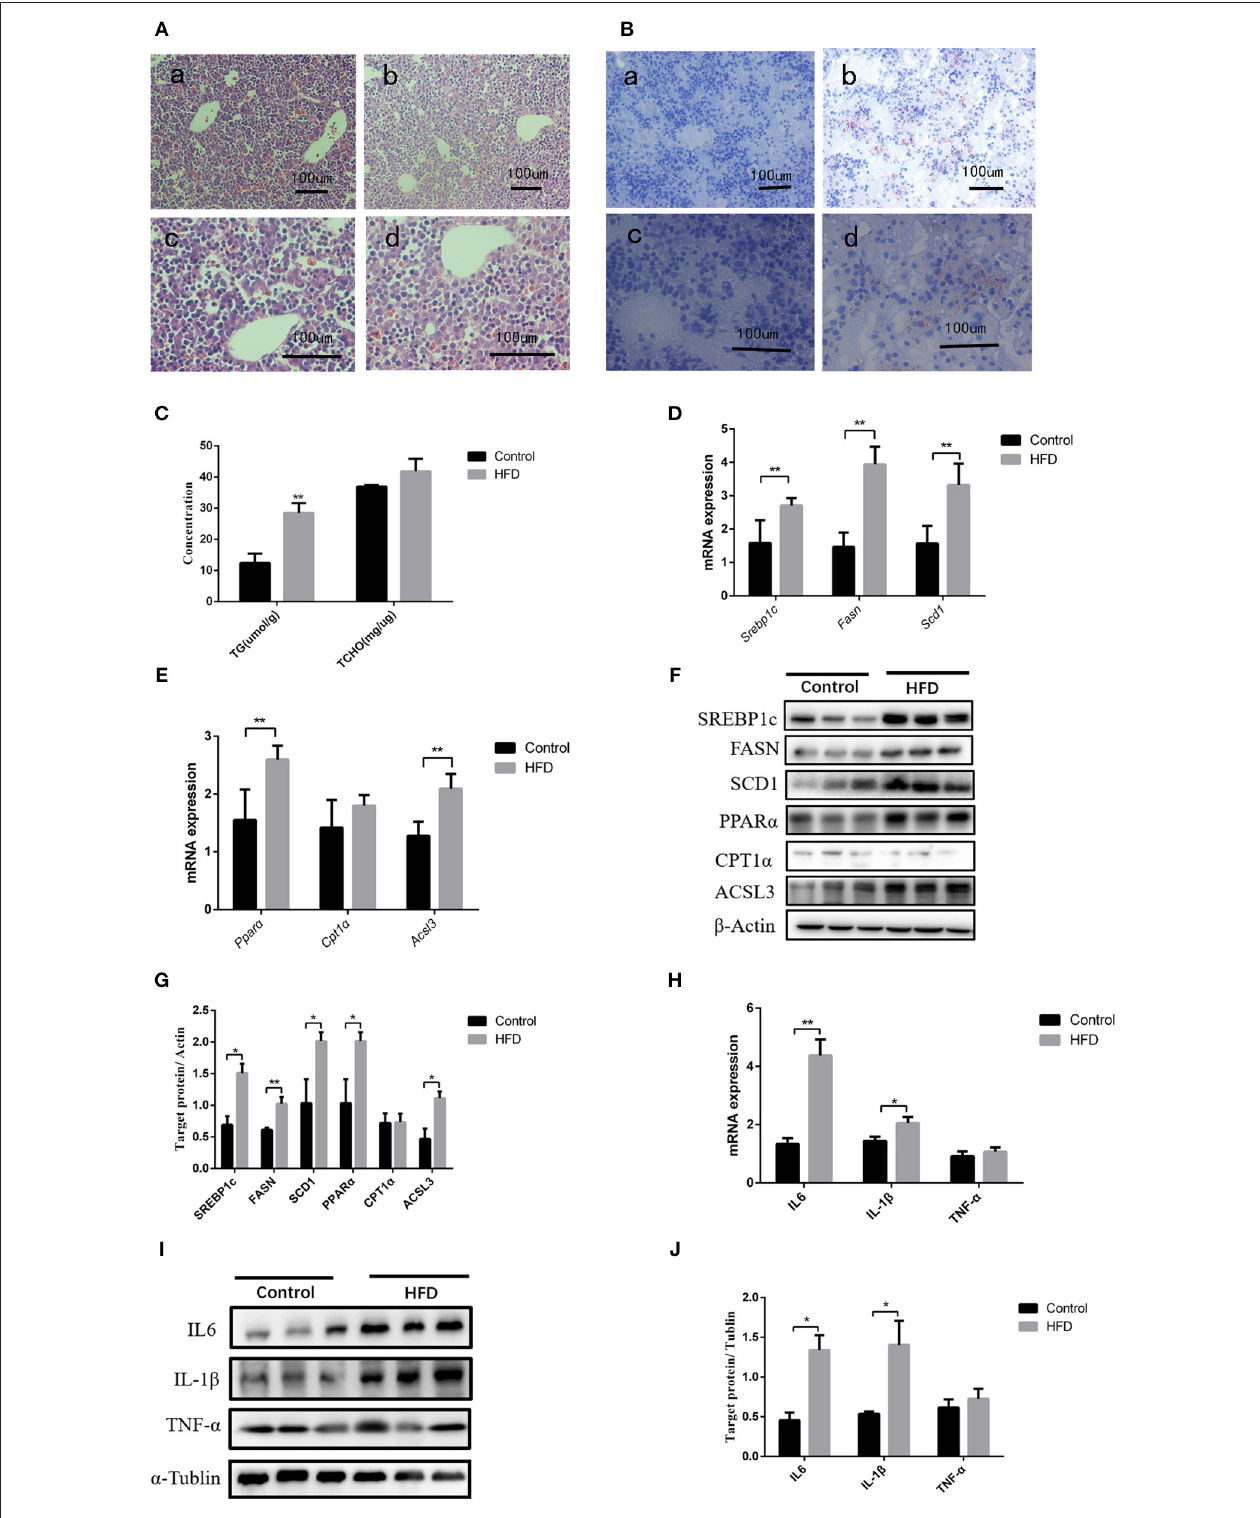
FIGURE 1 | Pathological phenotypes and gene expression of lipid metabolism and inflammatory genes in neonate livers. (A) Hematoxylin and eosin (H&E) staining of neonate livers from F0-CON dams [(a): 200X; (b): 400X] and F0-HFD dams [(c): 200X; (d): 400X]. (B) Oil red O staining of neonate livers from F0-CON dams [(a): 200X; (b): 400X] and F0-HFD dams [(c): 200X; (d):400X]. (C) Comparison of hepatic lipid levels between the neonates from F0-CON and F0-HFD dams. (D) Comparison of